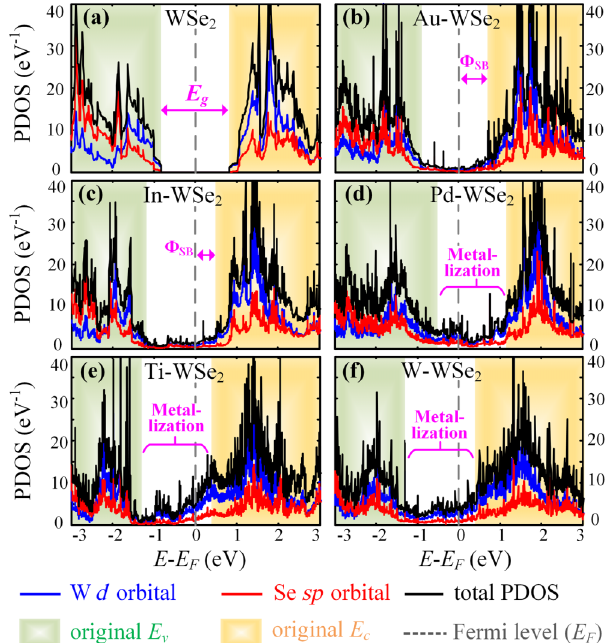
FIG. 12. PDOS of top contacts to WSe 2 : (a) only WSe 2 , (b) Au-WSe 2 , (c) In-WSe 2 , (d) Pd-WSe 2 , (e) Ti-WSe 2 , (f) W-WSe 2 . E denotes Fermi level. F